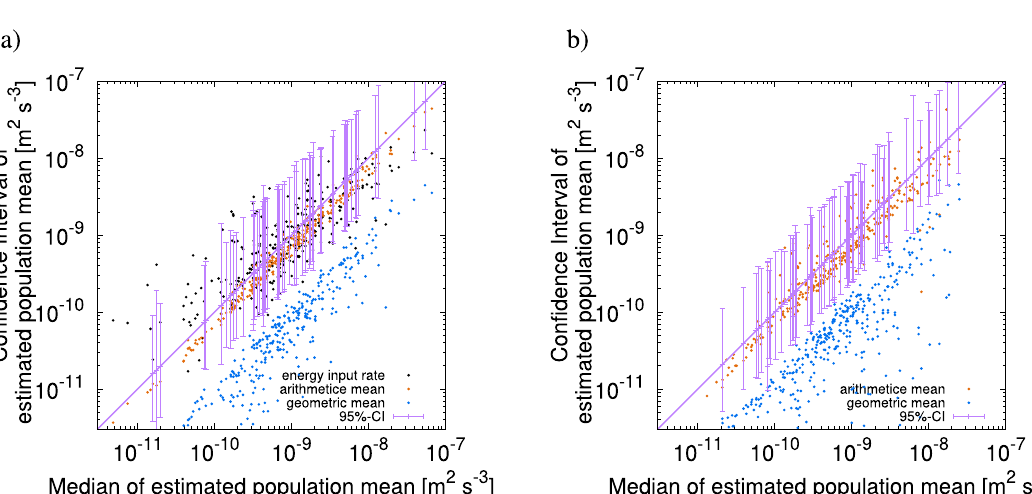
γ indicates the (cid:31)